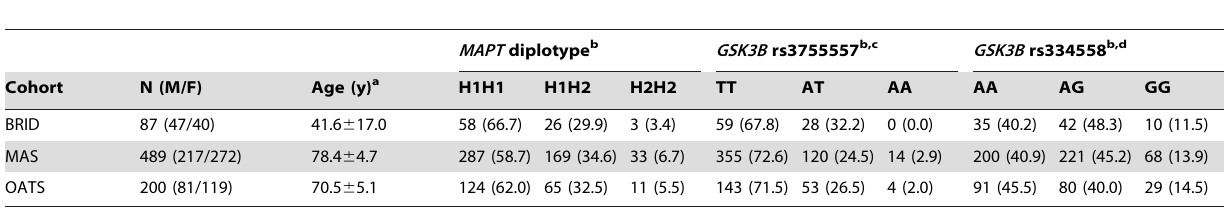
Table 1. Demographics of cohorts examined in this